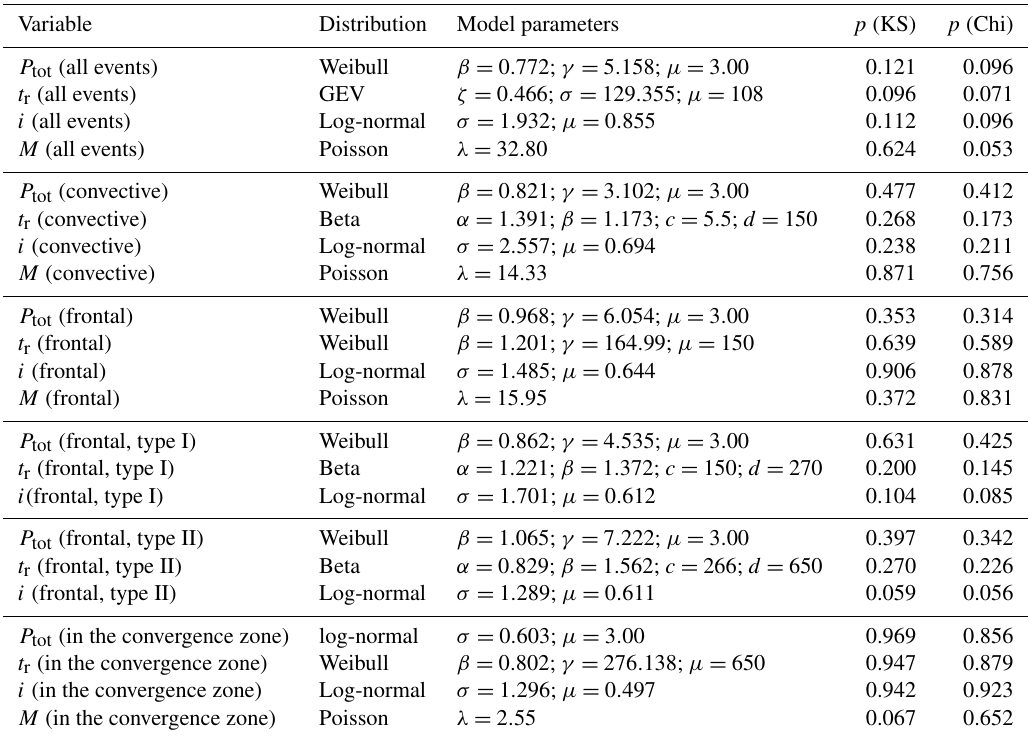
Table 2. Results of KS and Chi tests and parameters of theoretical models for the considered random variables ( P tot , t r , i , and M ) depending on rainfall